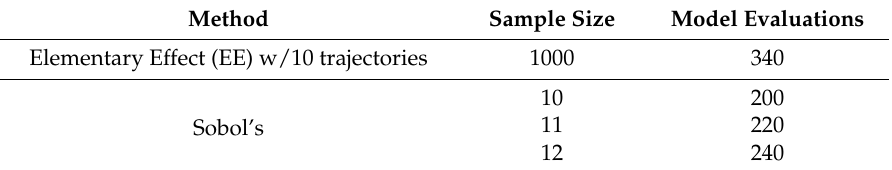
Table 4. Sampling sizes and number of model runs performed for each sensitivity analysis